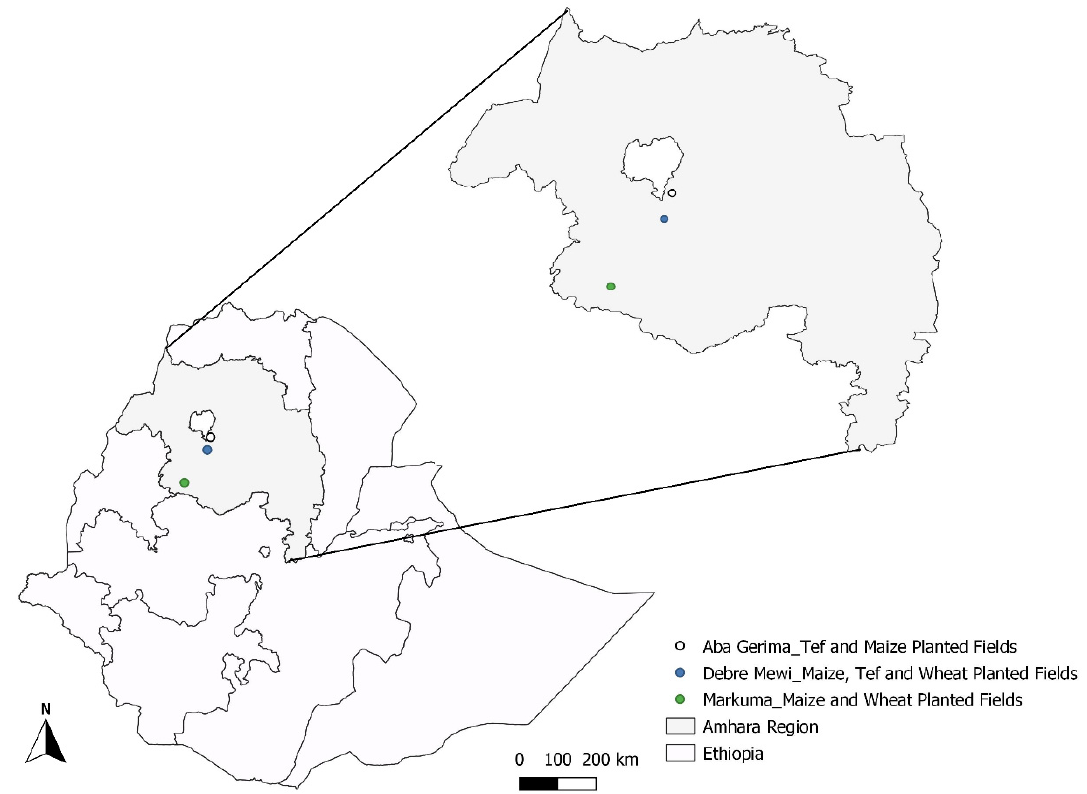
Figure 1 . Location of the study sites in the Amhara region, Ethiopia . Figure 1. Location of the study sites in the Amhara region,